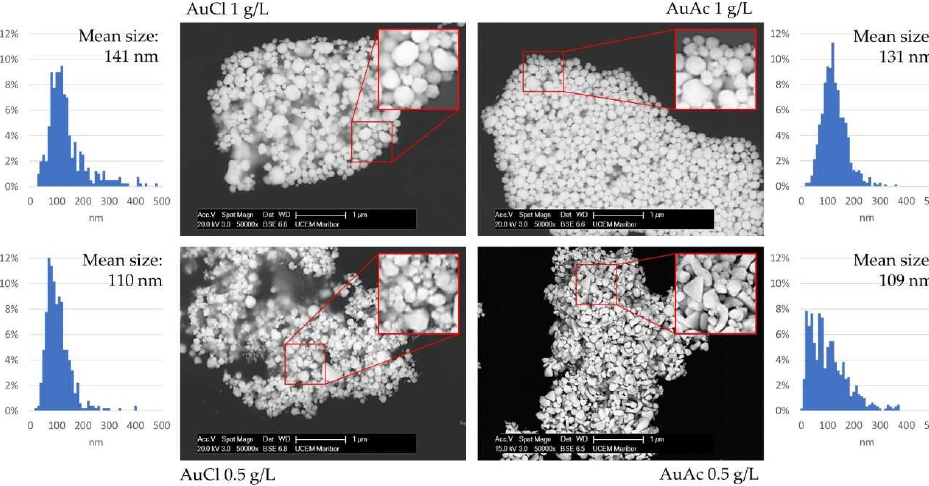
Figure 6. SEM micrographs of AuNPs taken from suspensions synthesised through USP, with corresponding size distributions from